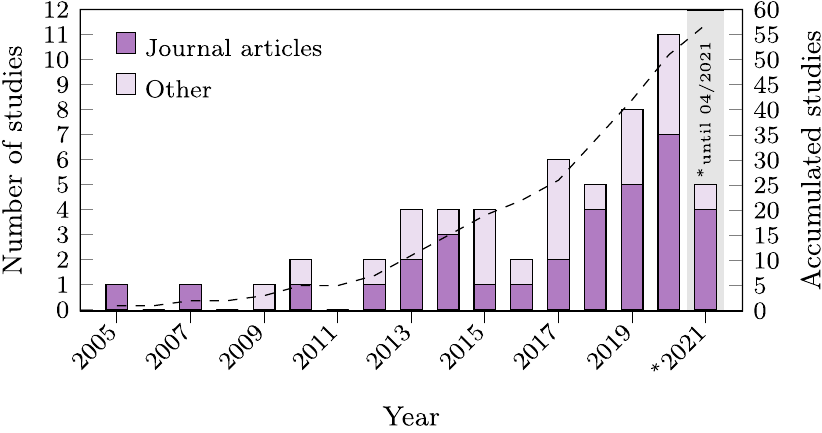
FIG. 3. Number of eye-tracking studies in PER per year (left vertical axis) and in total (right vertical axis). For 2021, all articles published until the end of April have been included.